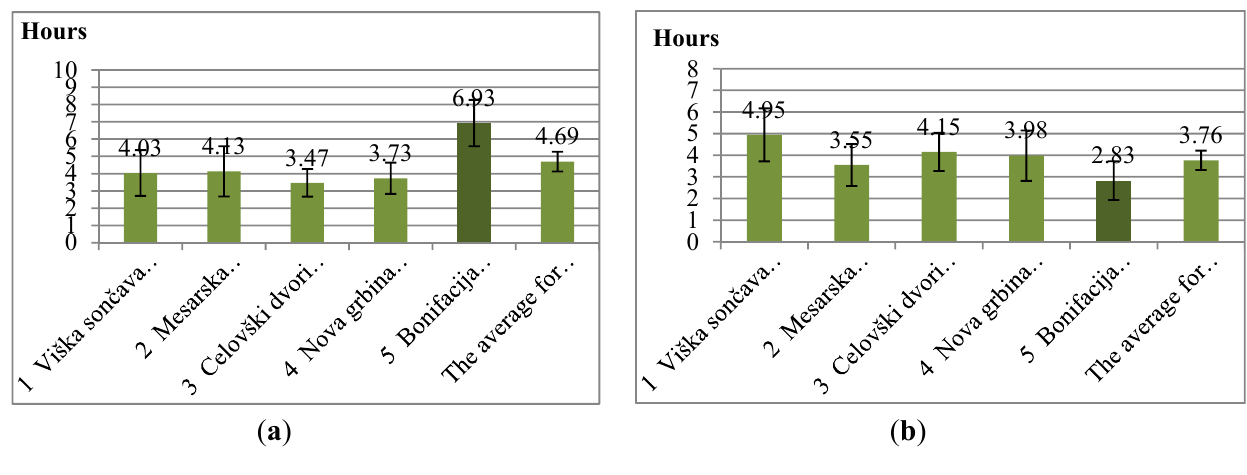
Figure 4. Left: Time in hours per week spent outdoor in residential area. Right: Time in hours in spend in patios and balconies (95% Confidence Interval of the